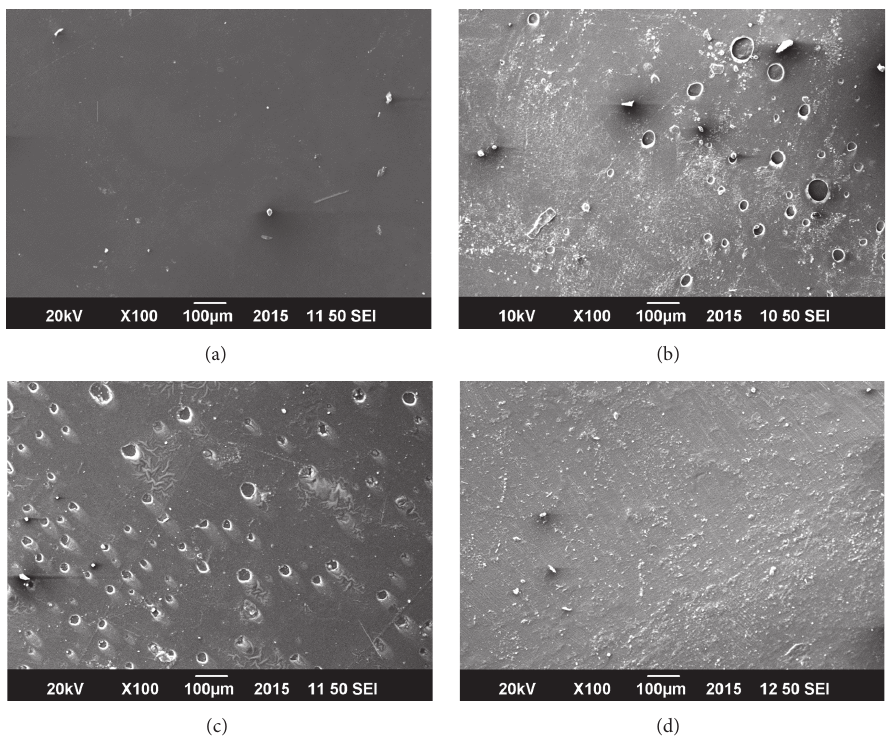
Figure 1: SEM images of Aloe vera /polymer films. (a) Film with 5% Aloe vera concentration at 20kV and × 100 magnification. (b) Film with 10% concentration at 10 kV and × 100 magnification. (c) Film with 15% at 20 kV and × 100 magnification and (d) with 20% concentration at 20 kV and × 100 magnification.